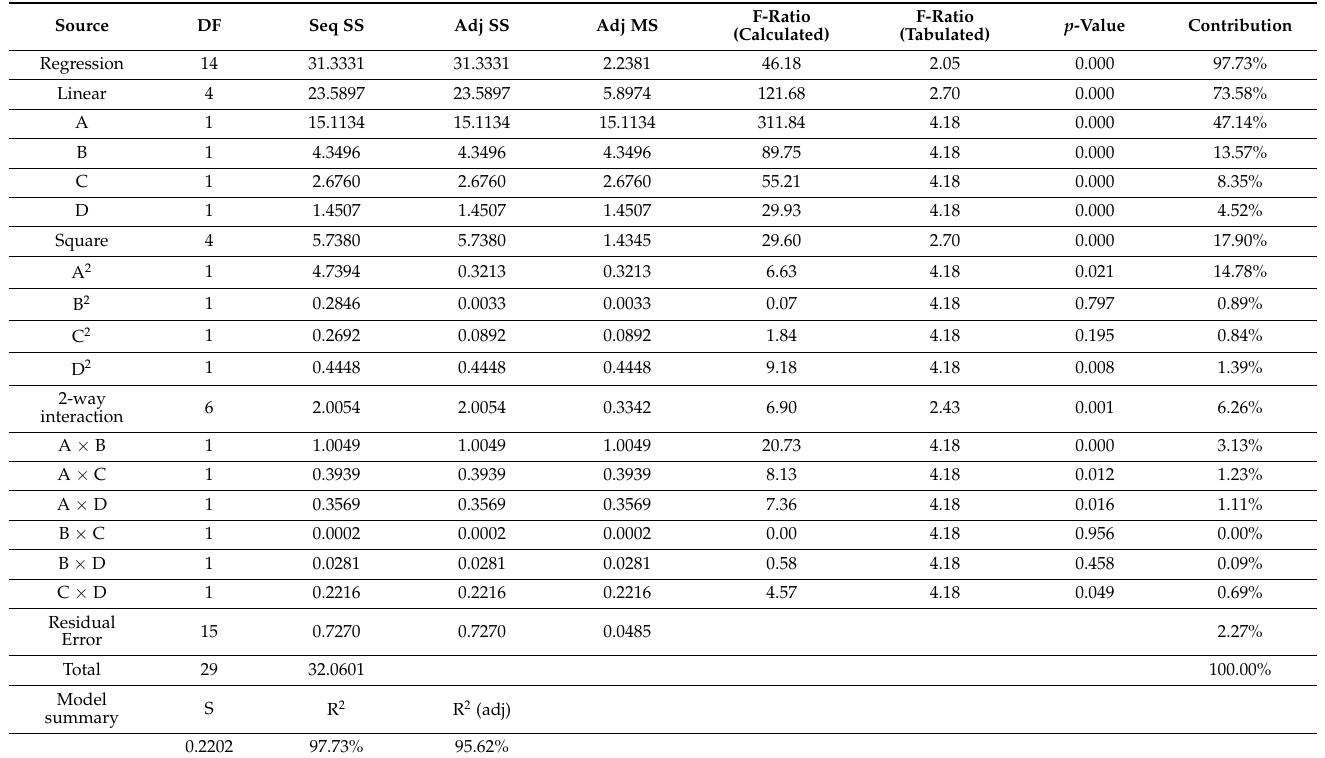
Table 16. ANOVA for surface roughness of h-BN-loaded